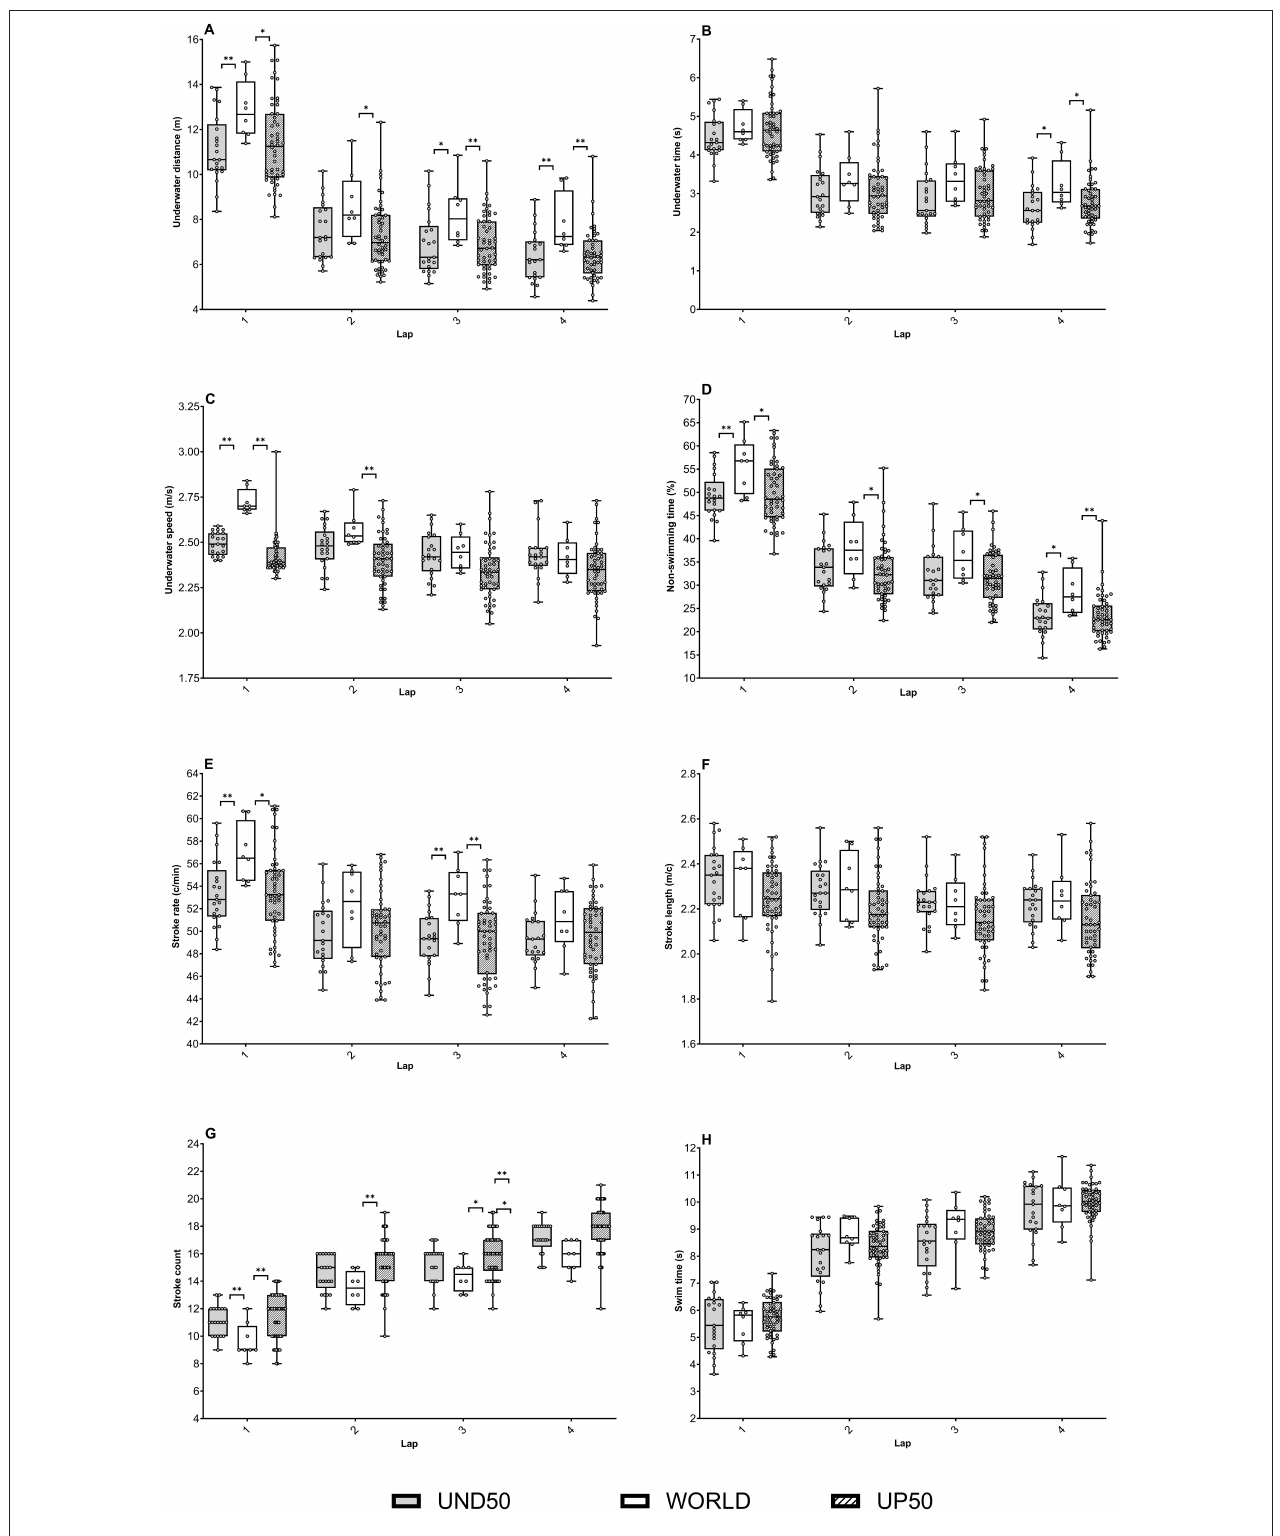
FIGURE 1 | Underwater and spatiotemporal parameters for the world finalists (WORLD), French swimmers under 50s (UND50), and French swimmers upper to 50s (UP50) over each lap of the 100-m freestyle race. (A) Underwater distance, (B) underwater time, (C) underwater speed, (D) non-swimming time, (E) stroke rate, (F) stroke length, (G) stroke count, and (H) swim time. Significant difference between the WORLD vs. UND50 and the WORLD vs. UP50: * p < 0.05, ** p < 0.01.